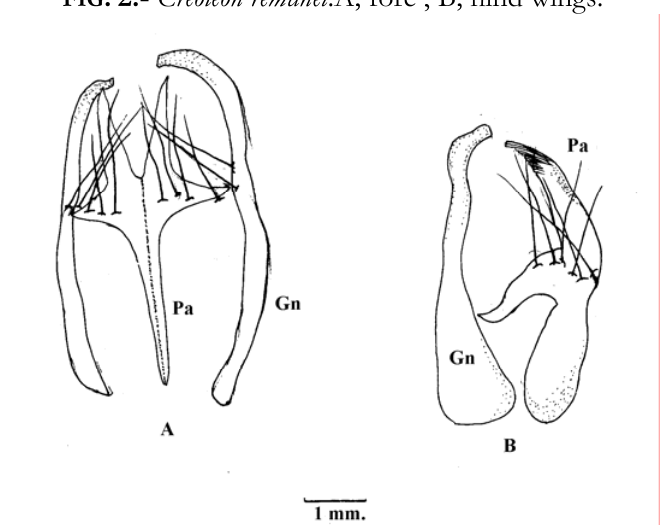
FIG . 2.- Creoleon remanei .A; fore , B; hind wings.